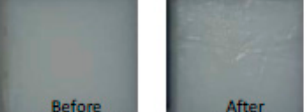
Figure 15. Erosion and char on spark plug anode electrode.